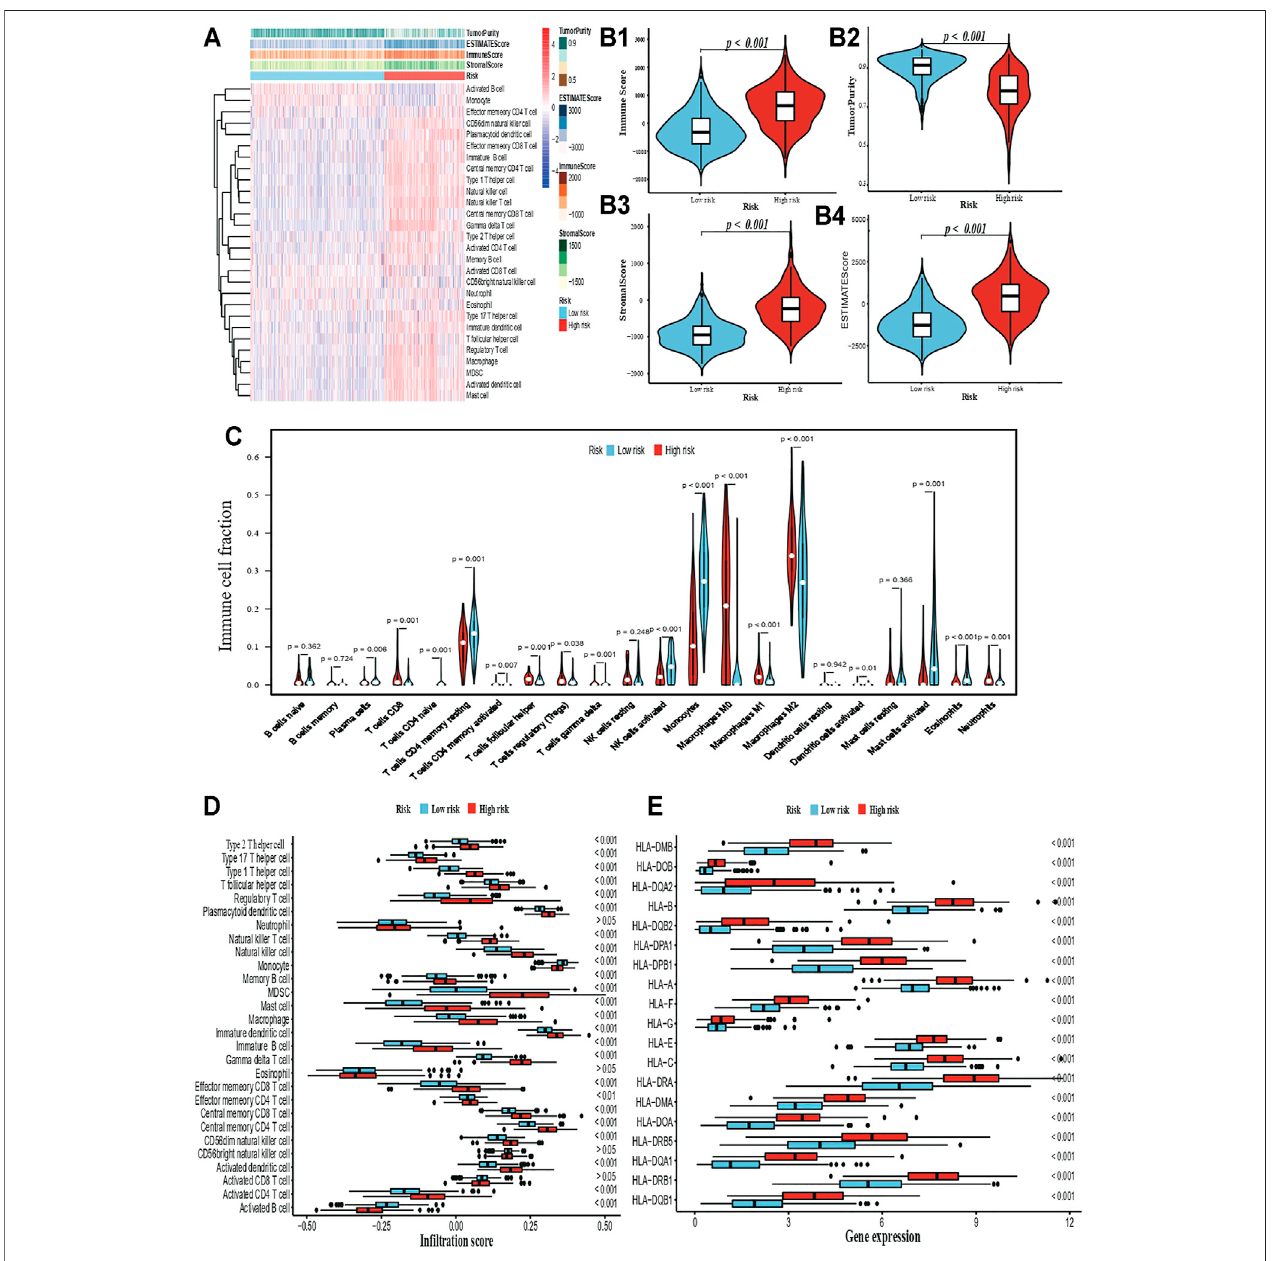
FIGURE 4 | Immune-related comparison. (A) The ssGSEA pro fi le. (B1-B4) Comparison for immune cell, tumor cell, and stromal cell in TME. (C) In fi ltration comparison based on the ssGSEA algorithm. (D) In fi ltration comparison based on the CIBERSORT algorithm. (E) Differential expression for HLA gene family.